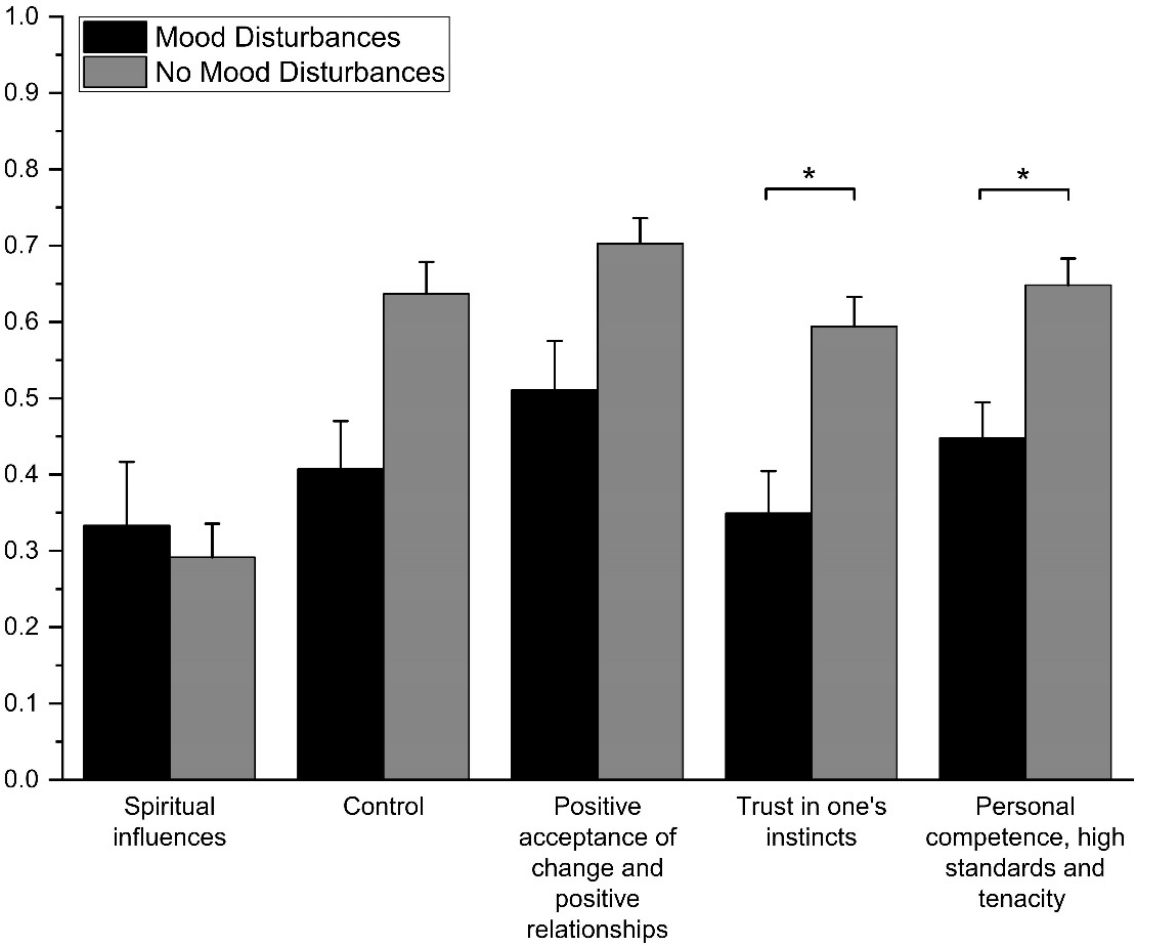
Figure 1. Differences in normalized CD-RISC-25 factor scores between patients with mood disturbances. CD-RISC-25 = Connor-Davidson Resilience Scale 25-items version. Asterisks denote statistically significant differences after Bonferroni correction (* = adjusted p < 0.05).